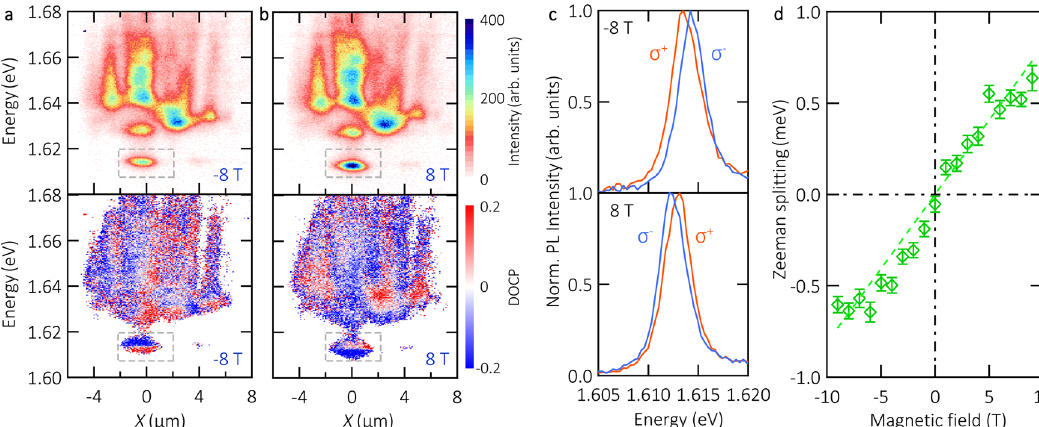
Fig. 2 Magnetic response of room temperature exciton-polaritons. a , b Polariton PL distribution intensity ( I σ + + I σ − ) (top panel) and corresponding DOCP (bottom panel) as a function of energy and real space coordinate at a magnetic fi eld of -8 T and 8 T, respectively. The pump power is 100 μ W. The intensity/DOCP is encoded in a linear false colour scale. Points in the ( I σ + + I σ − ) panels with <10% of the maximum intensity, are encoded in white colour in the bottom panels. A dashed grey box in these panels highlights the region of interest in this Zeeman study, corresponding to the trapped polariton state. c Normalized PL intensity of σ + (orange ) and σ − (blue) emission at magnetic fi eld of − 8 T (top) and 8 T (bottom). d Zeeman splitting as a function of the magnetic fi eld. The dashed line is a linear fi t with a slope of 0.081 ± 0.004meV/T. The error bars correspond to the 95% con fi dence interval of the Lorentzian fi t to the trapped polariton